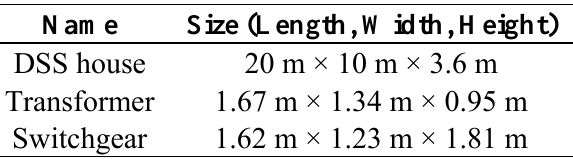
Table 1. Size of objects in the